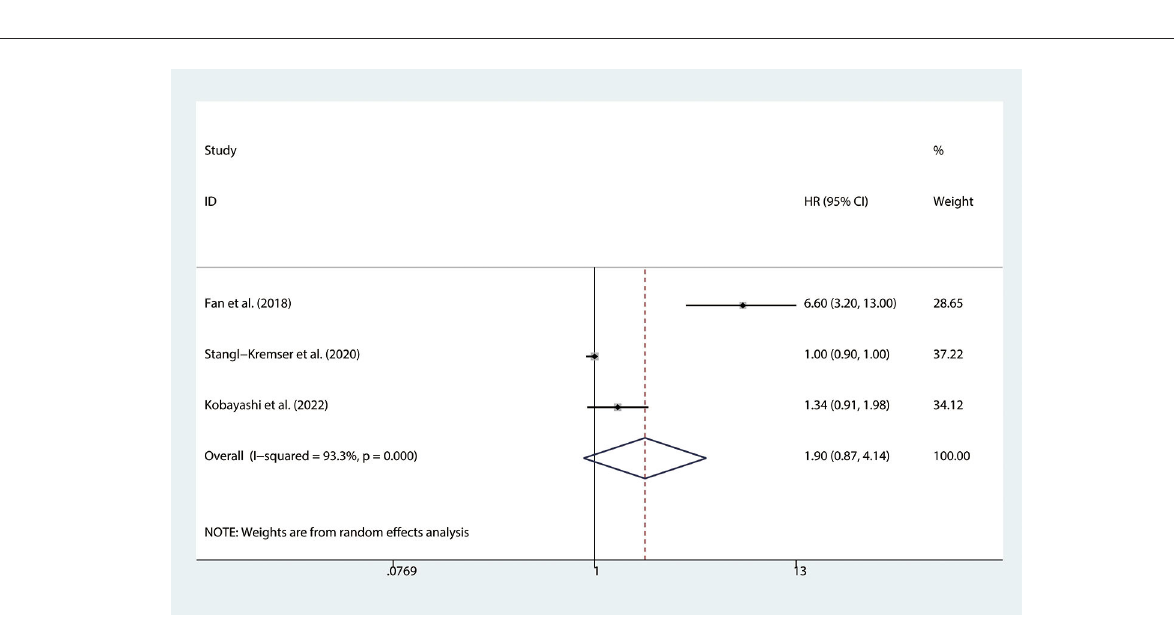
pathologically diagnosed with nmPCa and the treatment for these patients was surgical treatment, which was different from previous